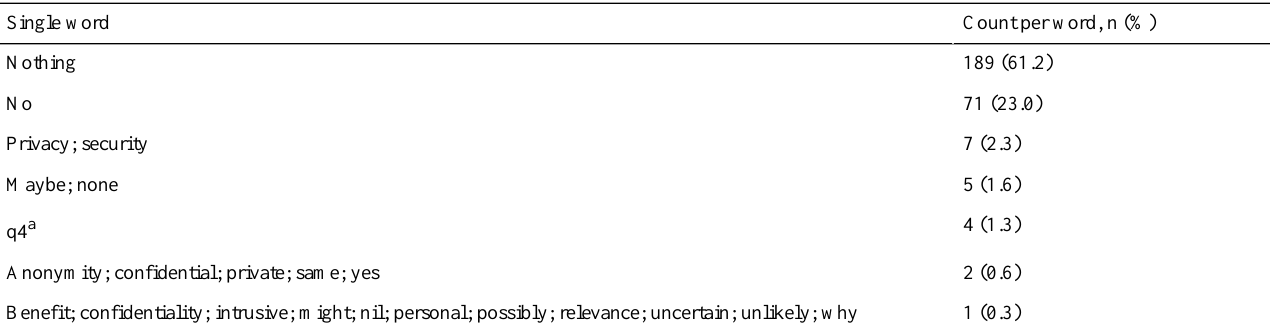
Table 2. Counts of single-word responses to the question, “What (if anything) might make you change your mind in the future?” about sharing fitness app data for linkage with health records